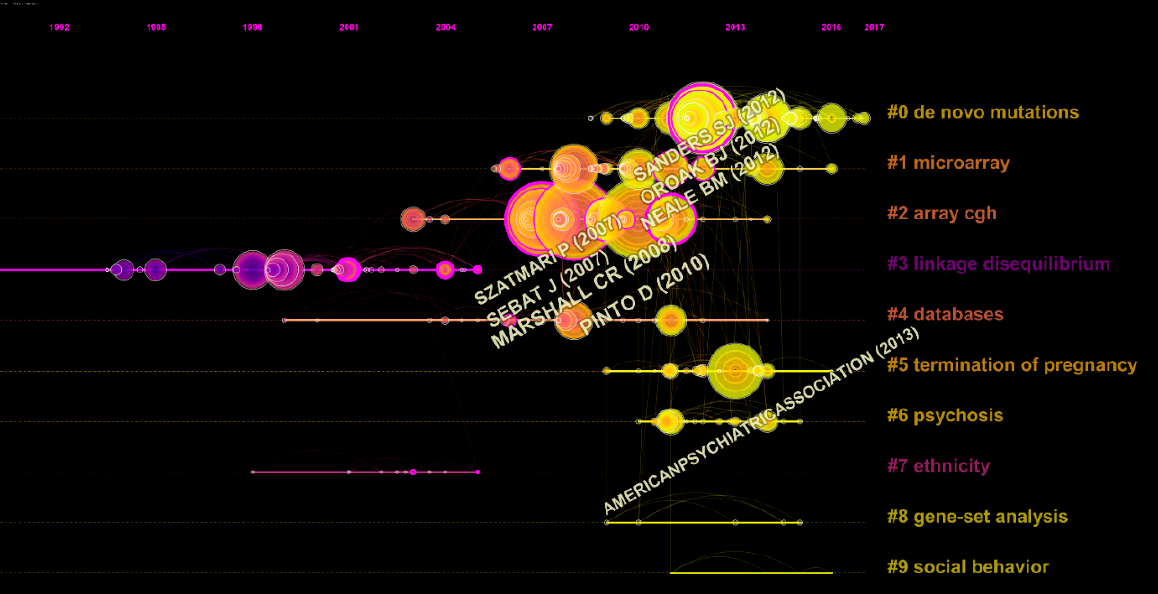
Figure 6. Co-occurrence network of terms of genetic factors in ASD publications from 1997 to 2018. The most common terms used in the scientific literature were investigated to identify relationships between the extracted terms and new aspects and the applied technologies. Terms were automatically exacted from titles and abstracts and divided into four clusters by the natural language processing techniques of VOSviewer. 3.5. Visualization Analysis of Focus Transfer and Research Frontiers To obtain the frontier topics and research tendency, keywords with the strongest ci- tation bursts in the scientific literature were analyzed and visualized in a keywords burst map by the CiteSpace algorithm-dependent analytical tool, aligned based on their time of appearance (Figure 7). The keywords burst map contained two key points: the strength